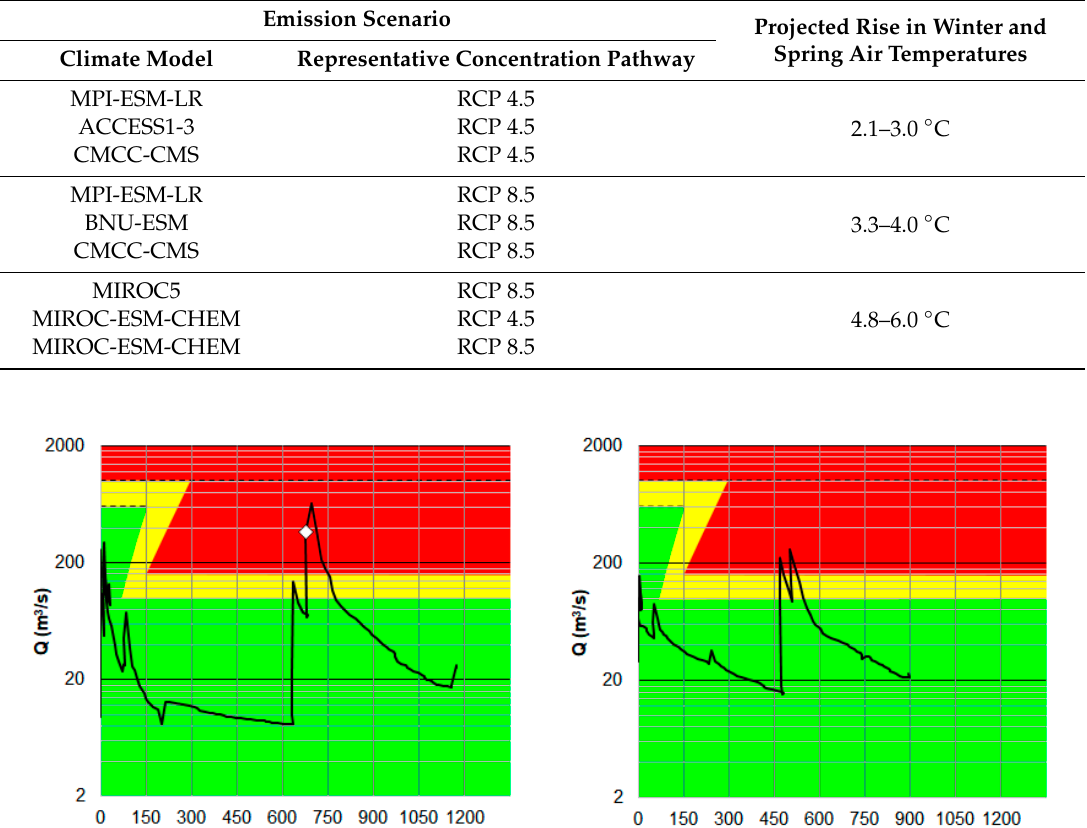
Table 3. Range of average rise in winter and spring air temperatures for each river based on Model-RCP combinations.